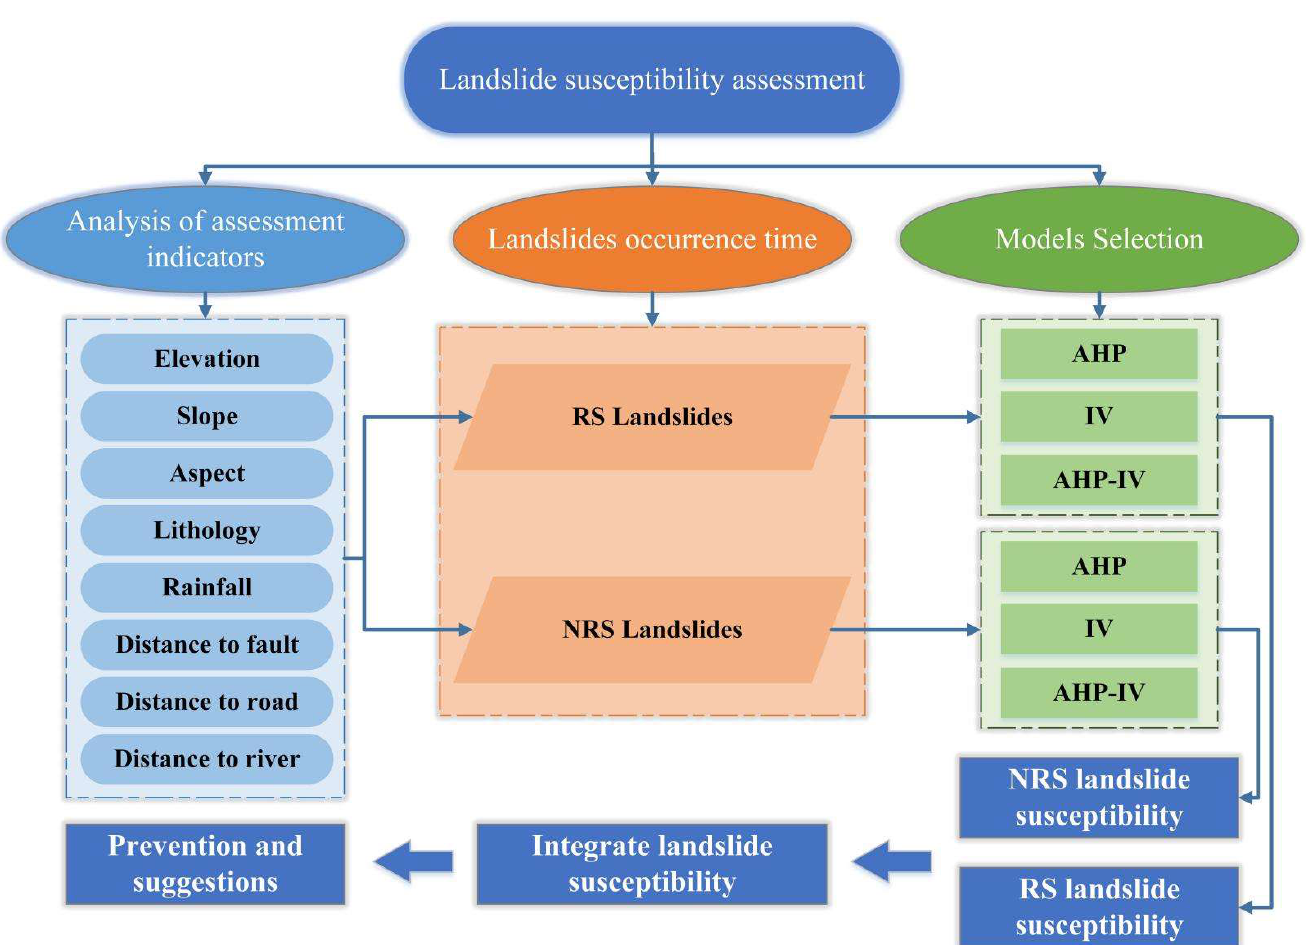
Figure 2. Technical route.